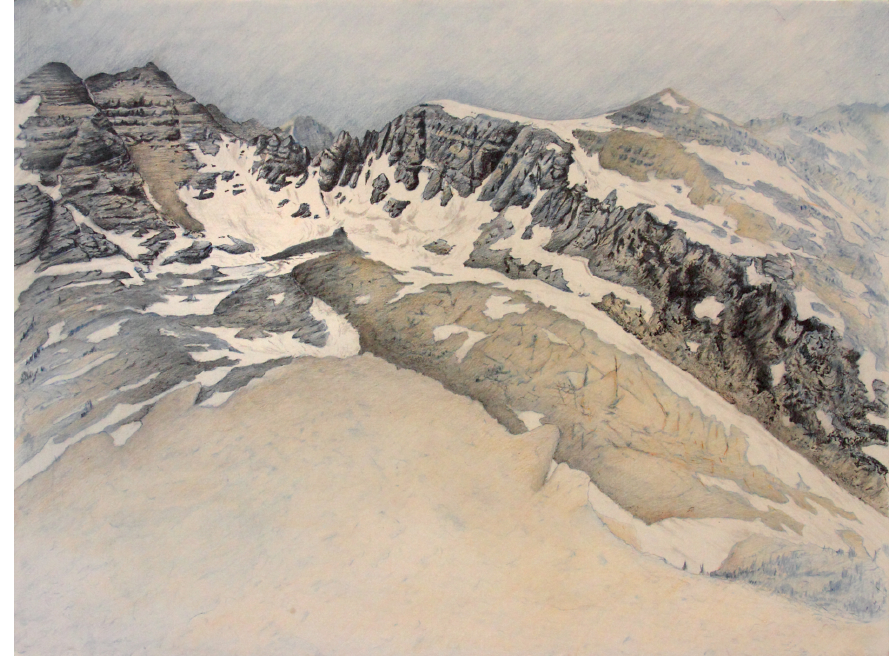
Figure 2: Fissure Glacier - Mission Mountain Wilderness, MT from the Glacier Drawing Project, 2015. Graphite and color pencil on paper, 18" x 24". Courtesy of Jonathan Marquis. Downwaste gallery available at: